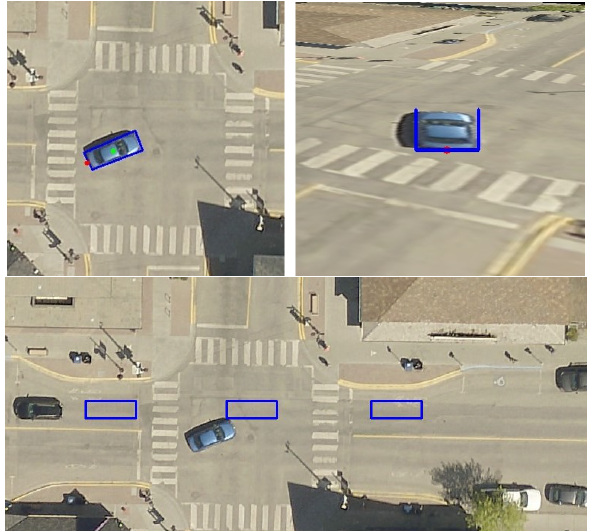
Figure 8. Pedestrians center ground points